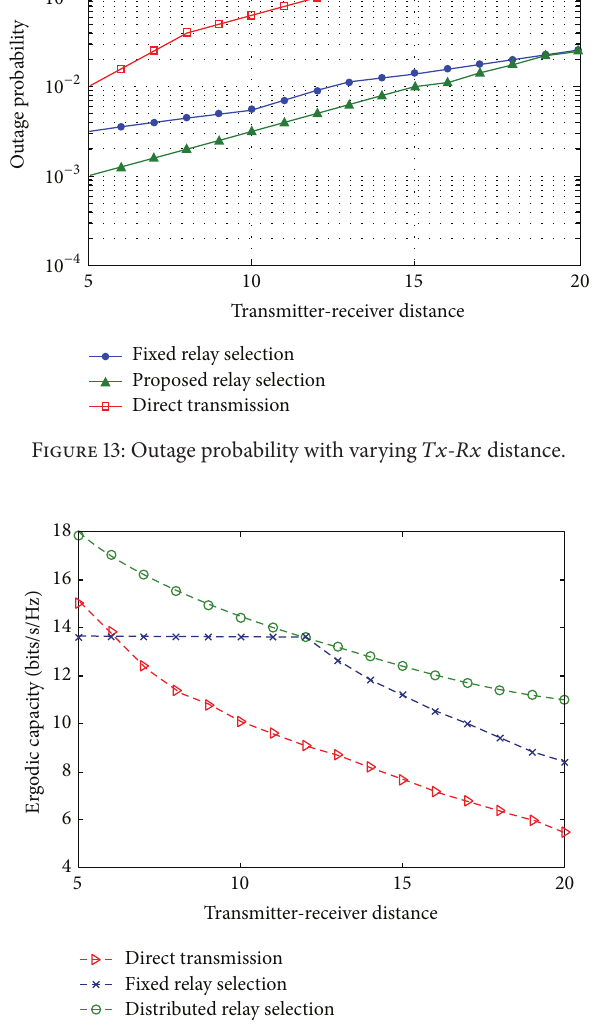
Figure 14: Ergodic capacity with varying 𝑇𝑥 - 𝑅𝑥 distances.